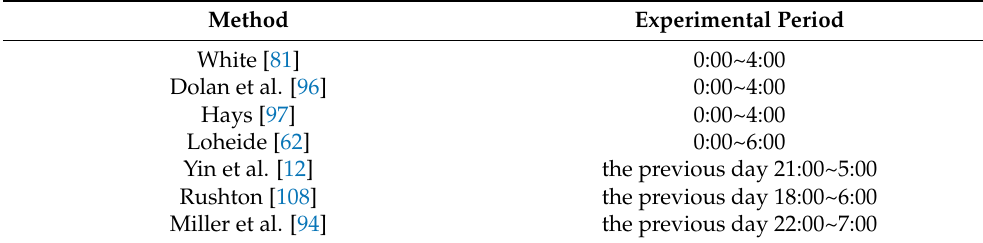
Table 1. The time periods selected for water table recovery rate calculation in different